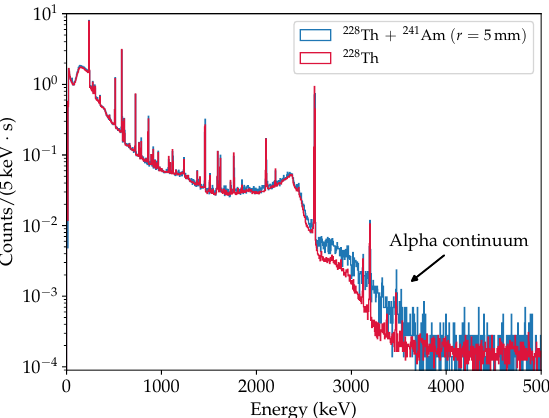
Figure 8. Energy spectra as measured with the 228 Th and the 241 Am source at the position r = 5mm (blue curve), and the 228 Th source only (red curve). At higher energies, a continuum of alpha events is